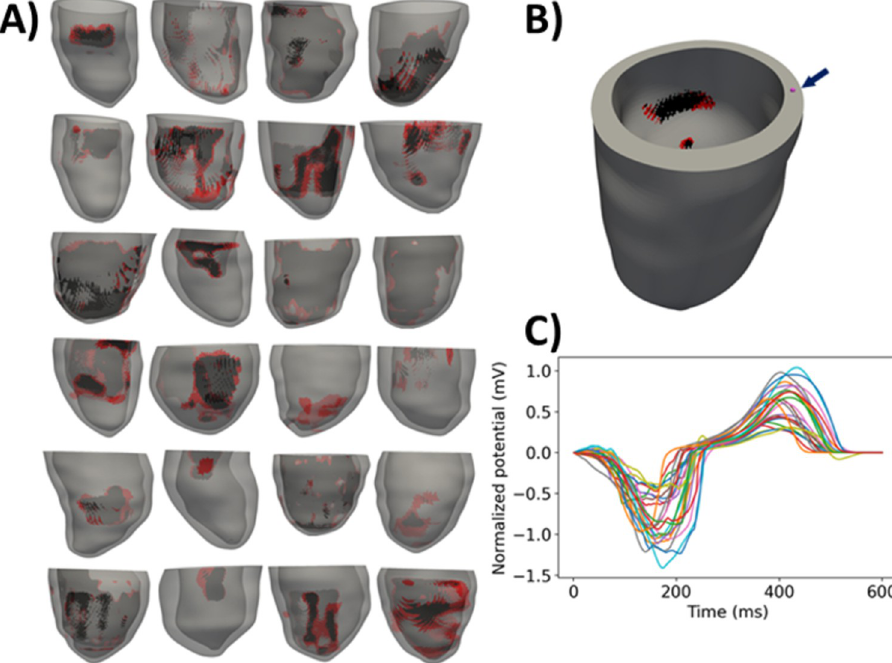
Fig 3. A): left ventricular meshes for 24 patients (red–border zone; black–scar). B) base timing location for one patient. C) simulated V1 ECG for all patients (note: apical pacing not sinus